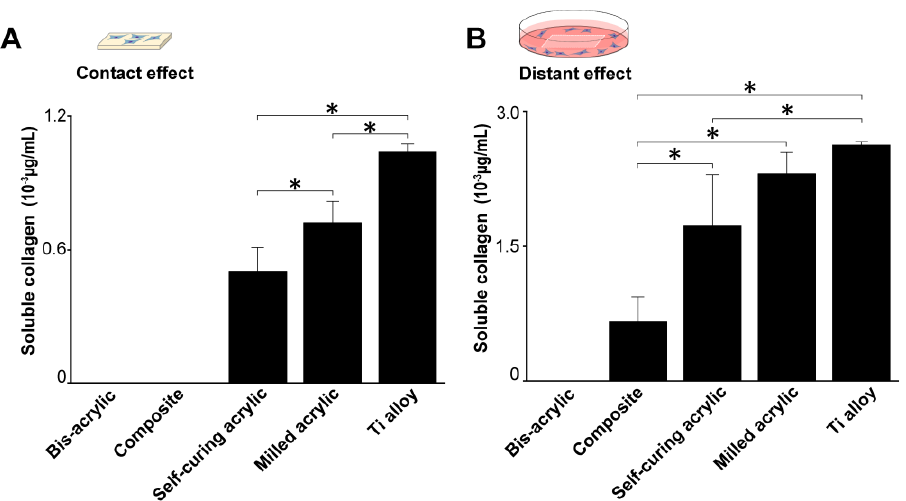
Figure 6. Collagen production by fibroblasts 4 days after seeding. ( A ) Collagen production on test materials and ( B ) around test materials. Data shown are means ± SD (n = 3). Significant differences are shown (one-way ANOVA with Bonferroni post hoc test, * p < 0.05).